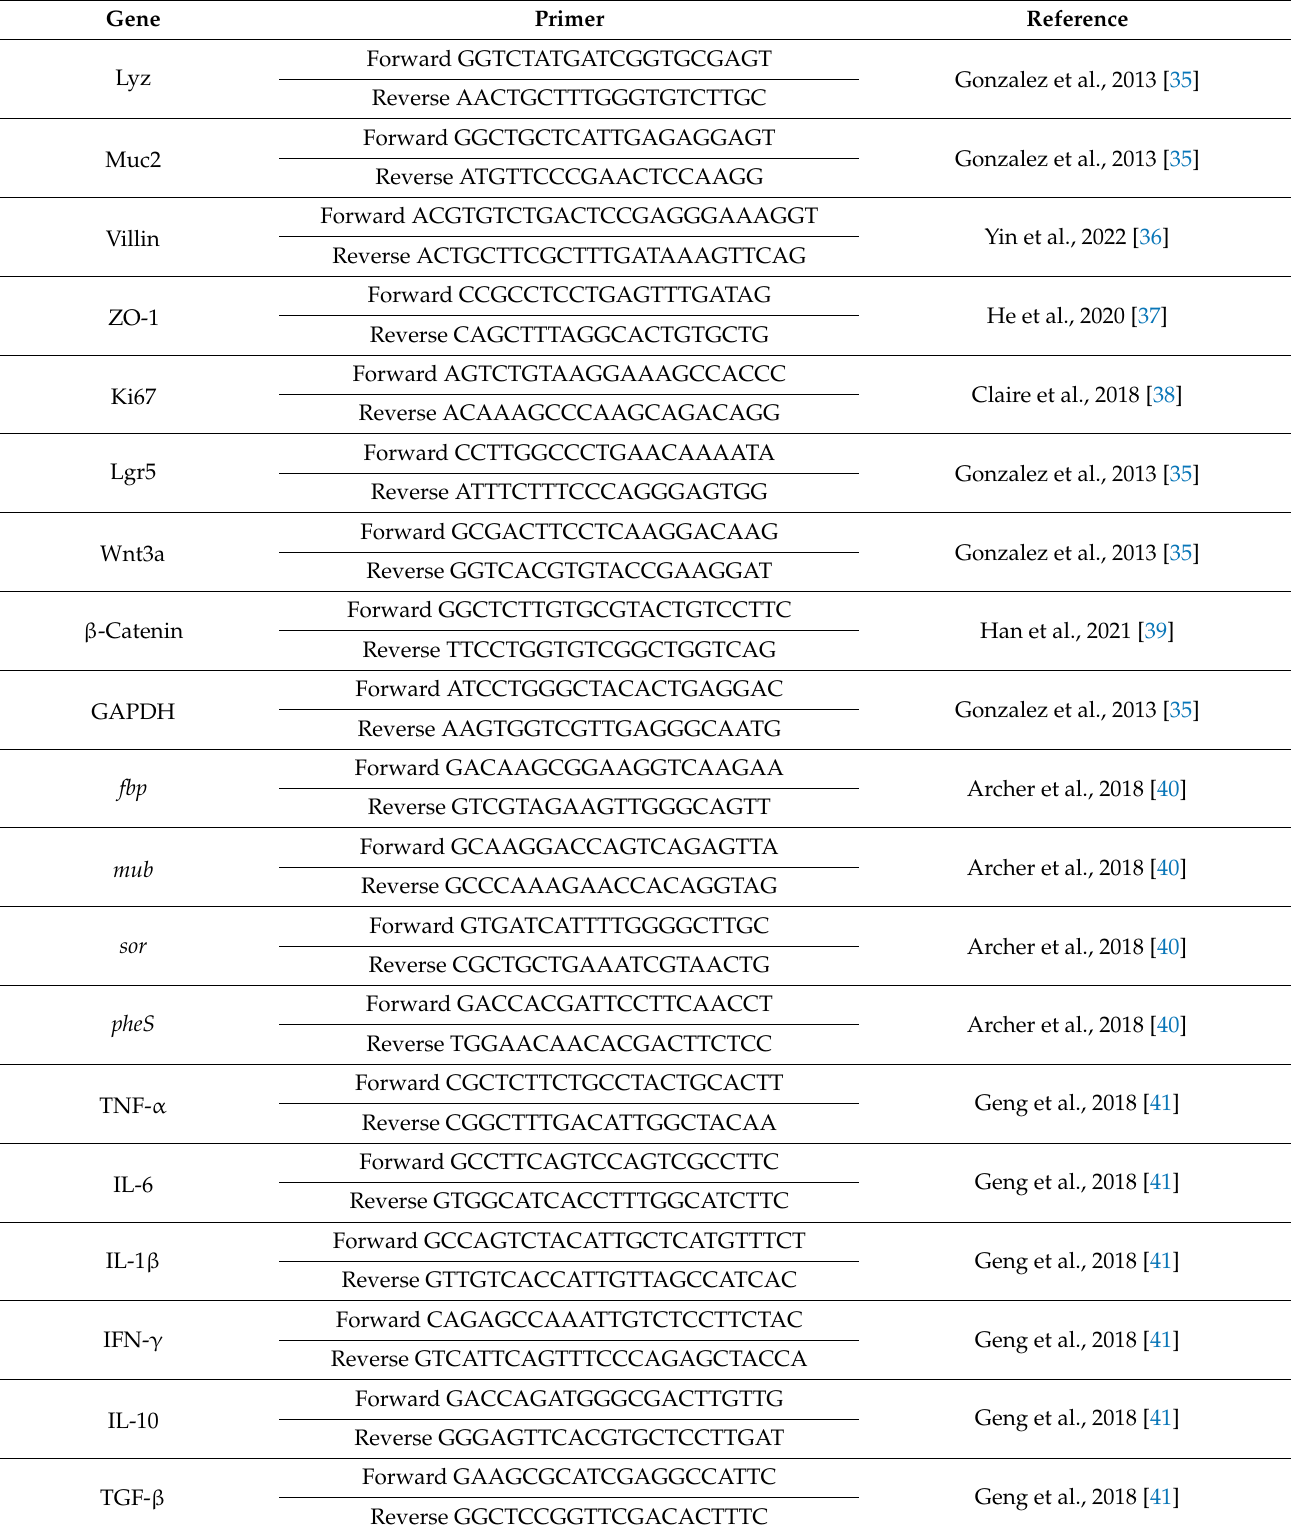
Table 1. Primers used for